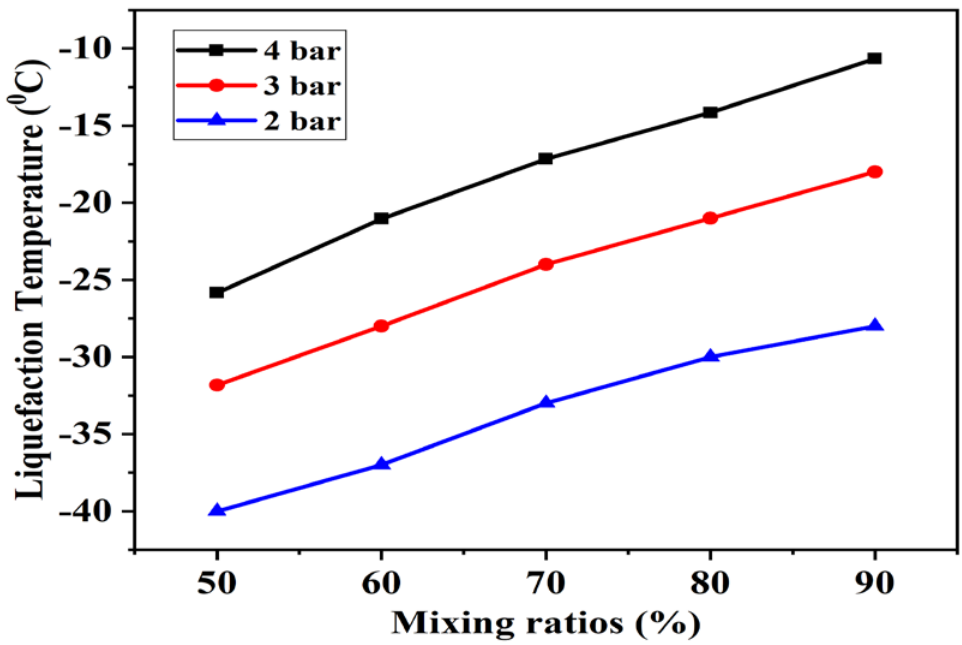
Figure 9. Liquefaction temperature of R152a at different pressure and mixture ratio.